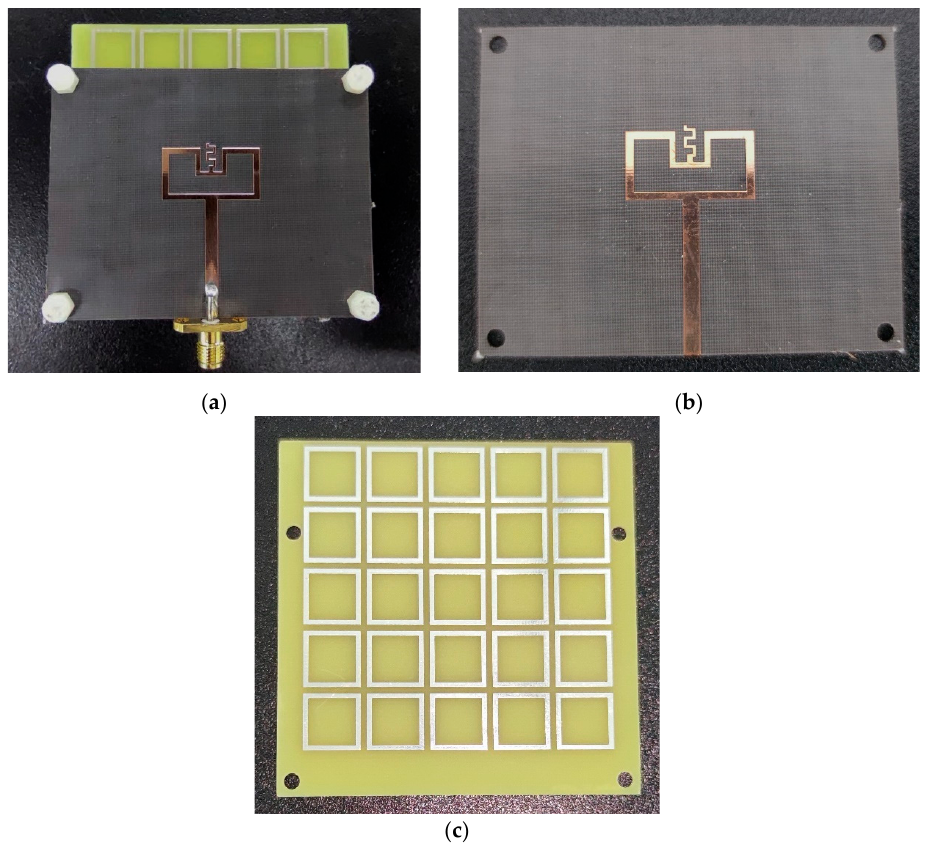
Figure 10. Photographs of the proposed antenna. ( a ) The integration of the prototype antenna and the FSS, ( b ) the prototype antenna, ( c ) the prototype of the 5 × 5 FSS.